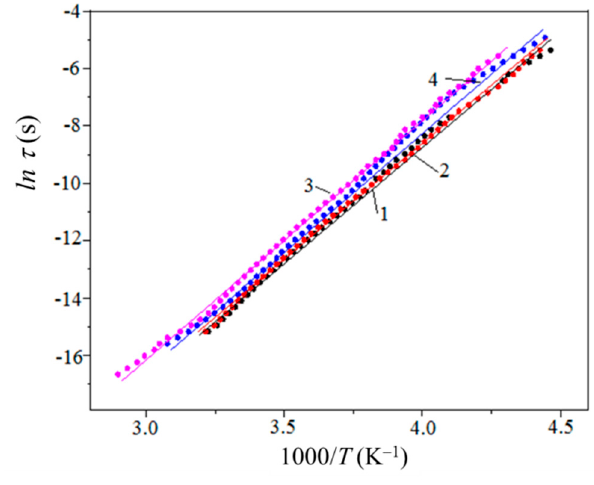
Figure 15. Temperature dependences of the logarithm of the dipole relaxation time for the neat resin (1) and MLG composites of 1% (2), 2% (3), and 5% (4) MLGs.